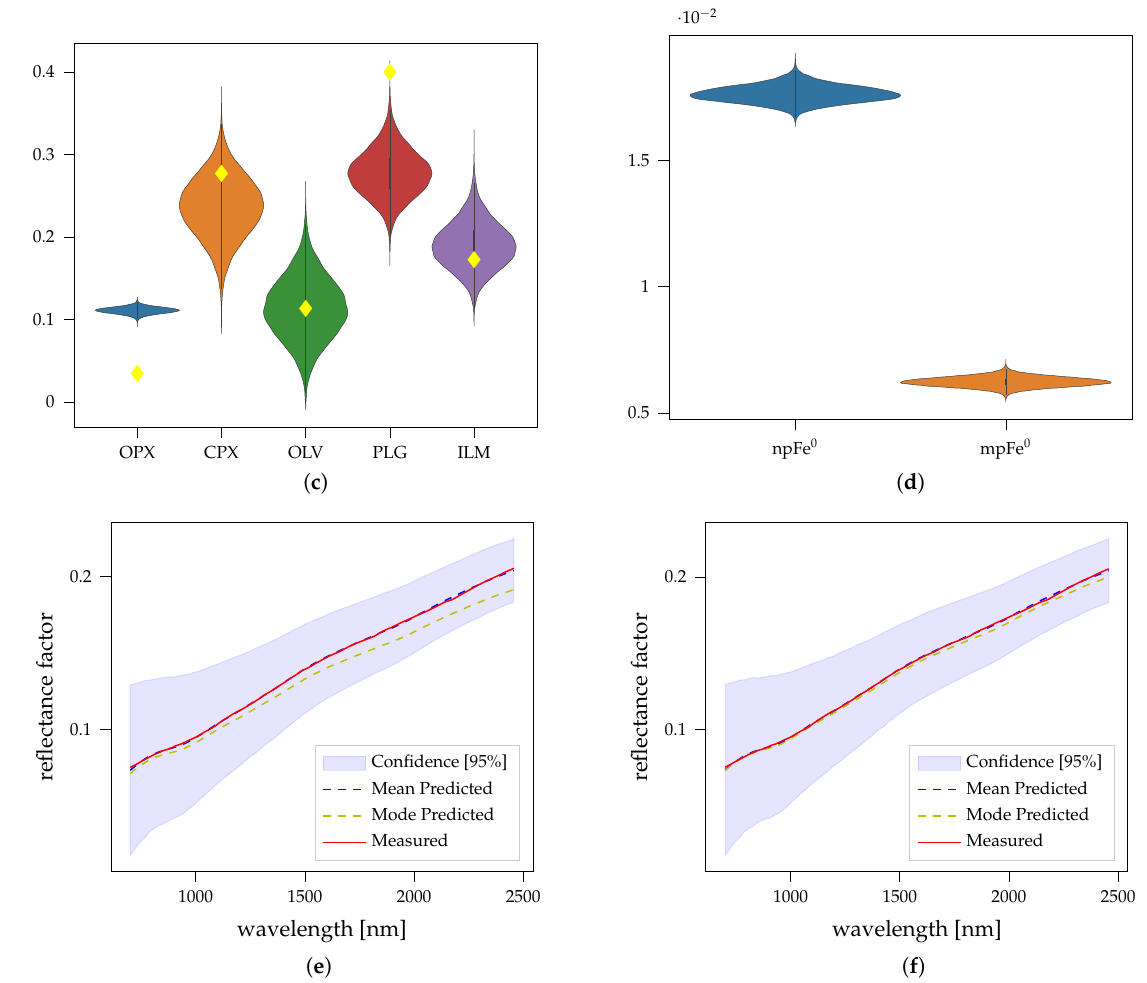
Figure 25. Results for LSCC sample 79221 both with the prior on TiO 2 and Al 2 O 3 abundance and a prior on all relevant elements. Including prior information about the other elements as well can help in mitigating uncertainties between clinopyroxene and olivine. This is also a mature mare spectrum with an I s /FeO value of 91.0. Yellow diamonds mark the theoretical mineral fractional abundances. ( a ) Endmember abundances with Ti/Al prior (79221); ( b ) smFe abundances with Ti/Al prior (79221); ( c ) Endmember abundances all elements prior (79221); ( d ) smFe abundances all elements prior